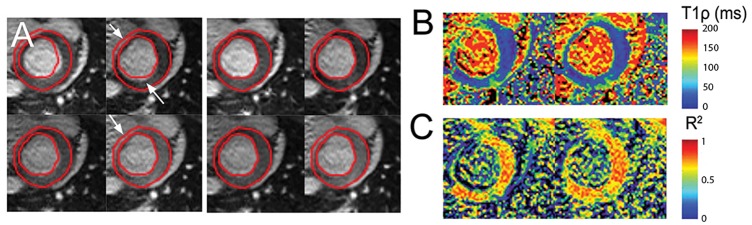
Motion correction of a T1ρ dataset in the moderate motion category.A, Top: Original images showing large motion. Bottom: Results of motion correction by applying optical flow registration. B, T1ρ maps before (left) and after (right) motion correction. C, R2 maps before (left) and after (right) motion correction.